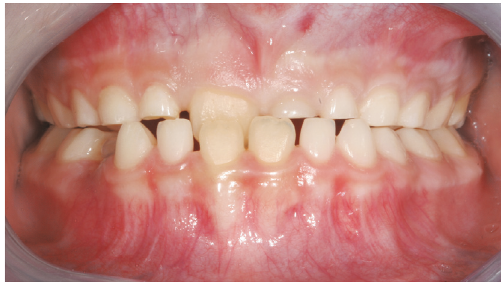
Figure 1: Frontal view of the patient class III occlusion.